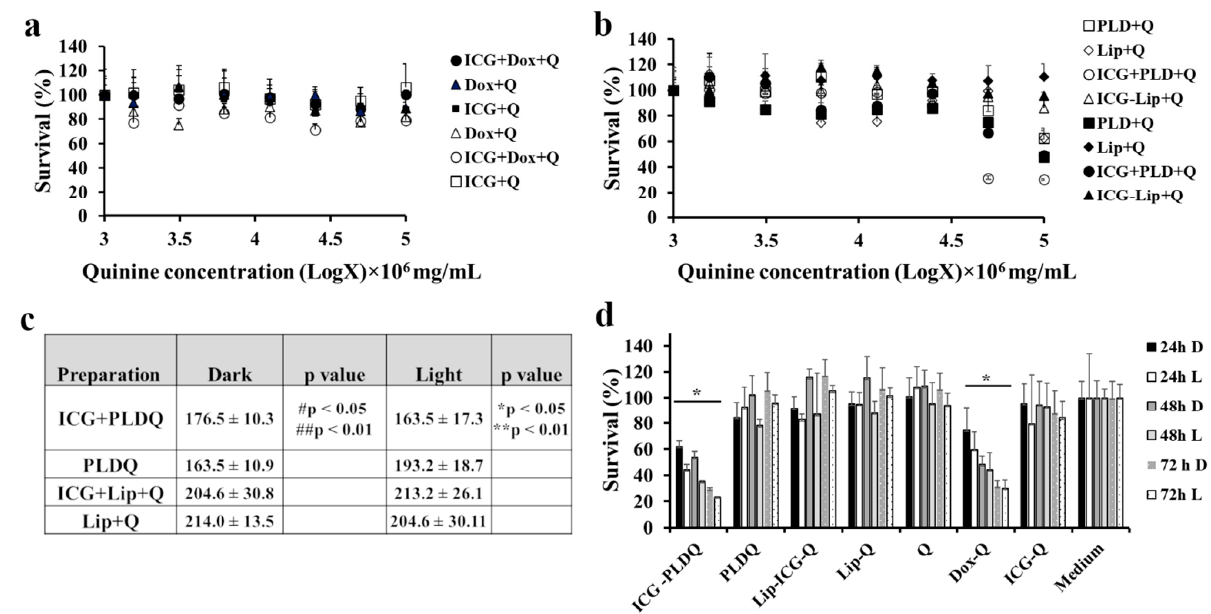
Figure 4. Effect of quinine, a P-gp inhibitor, on the survival of HT-29 MDR1 cells. ( a ). Toxicity of free doxorubicin, ICG, or combination of free drugs in HT-29 MDR1 cells. ( b ). Toxicity of liposomal doxorubicin, ICG, quinine, or combination of drugs in HT-29 MDR1 cells. ( c ). AUC of toxicity curves in HT-29 CT cells, based on Figure 2b, * p < 0.05 compared to ICG + PLDQ non-irradiated, PLDQ irradiated, ** p < 0.01 compared ICG-Lip + Q non-irradiated, Lip + Q non-irradiated/irradiated, # p < 0.05 compared to Lip + Q light, ## p < 0.01 compared to ICG-Lip + Q non-irradiated, Lip + Q non-irradiated. ( d ). Survival of HT-29 MDR1 cells in the presence of liposomal drugs or free drugs after 24, 48, and 72 h. D- not irradiated, L-irradiated, * p < 0.01 compared to the medium, n = 6/group; ANOVA with post-hoc Tukey Multiple Comparison Test. The filled and open markers represent non-irradiated and irradiated cells, respectively. Values represent mean ± SD.